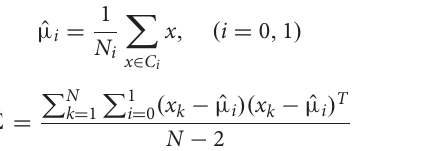
logarithms of the normalized power for the spatially projected signals were ultimately employed as the input features of the Bayesian linear discriminant analysis (LDA) classifier. The Bayesian LDA classifier assumed that the 2-class training data follow multivariate normal density distributions, and they